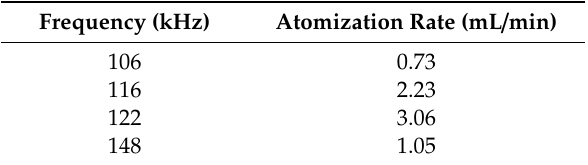
Table 3. Atomization rates at different driving voltages, when the driving frequency is 122 kHz. Voltage (V)